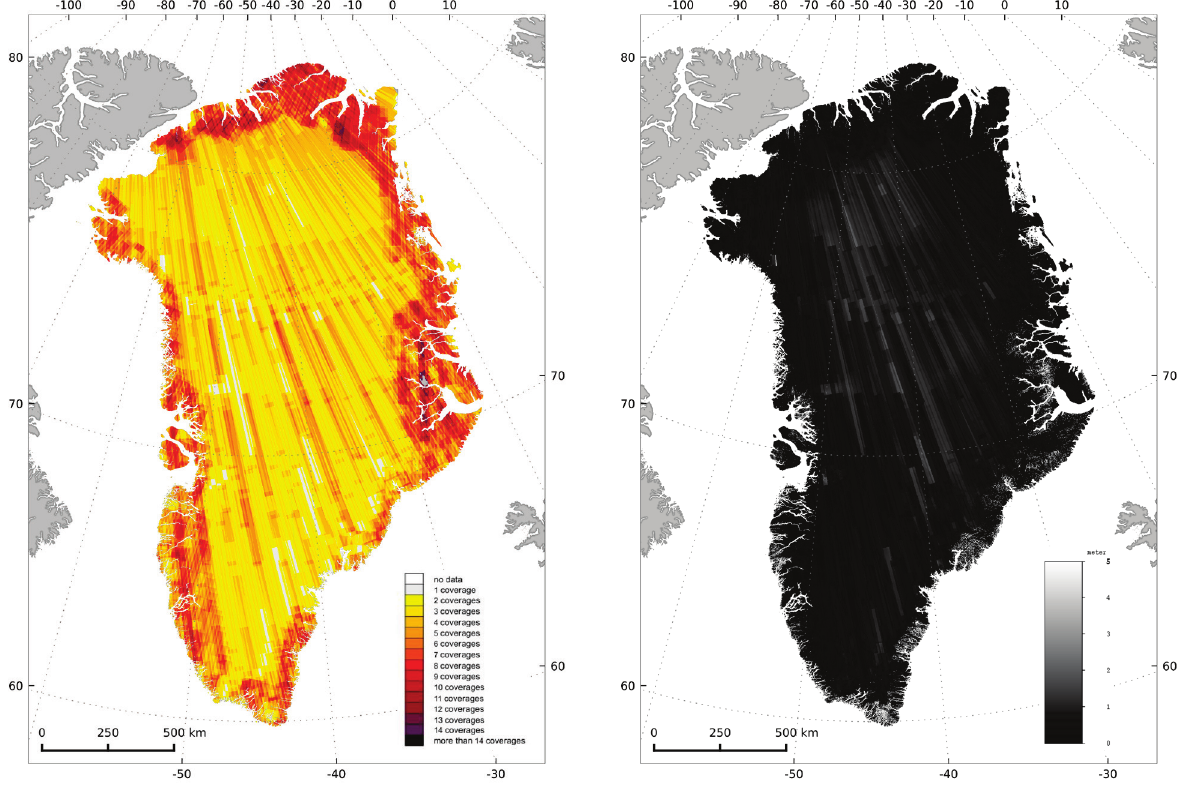
Figure 8. a) Number of coverages; b) resulting height error